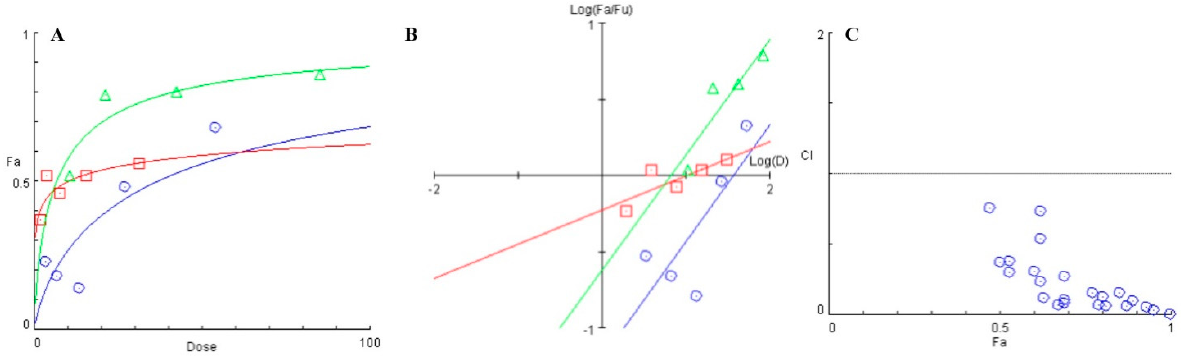
Figure 9. ( A ) Dose-response curve plotted between the fraction affected (fa) of biofilm formed and drug dose ( μ g/mL). ( B ) Median effect plot depicting the logarithmic transform of the ratio of the fraction affected (fa) and fraction unaffected (fu) as a function of the logarithmic transform of the dosage of individual treatment- ( ) baicalein, ( ) Fluoride and combi- nation ( ) of Baicalein and Fluoride. ( C ) Combination Index (CI) versus Fraction affected (fa) plot for various combina- tions of baicalein and fluoride when tested for S. mutans biofilm inhibition ( ) various combnations of baicalein and flu- oride.